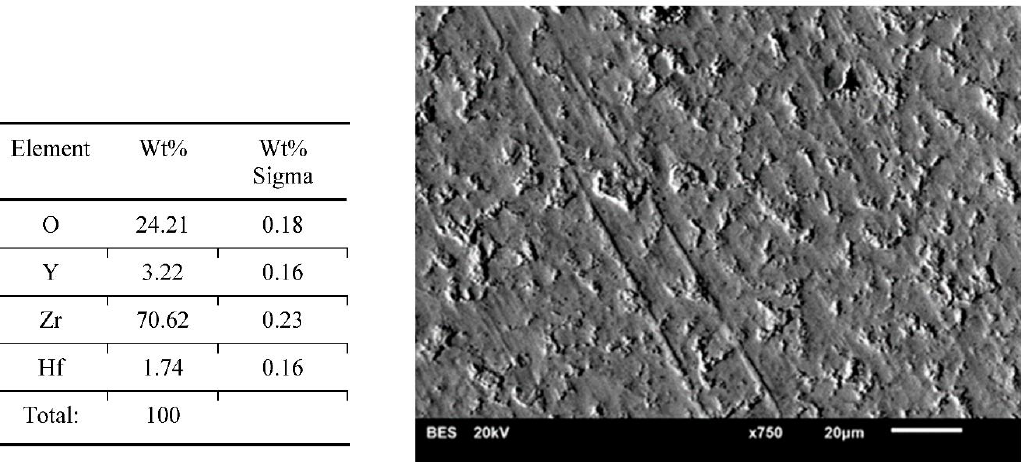
Figure 6. Chemical composition of the presented area and a backscattered electron image of a sample—dry ground 500 grit paper. Small features following lots of fine arrachments of the material.